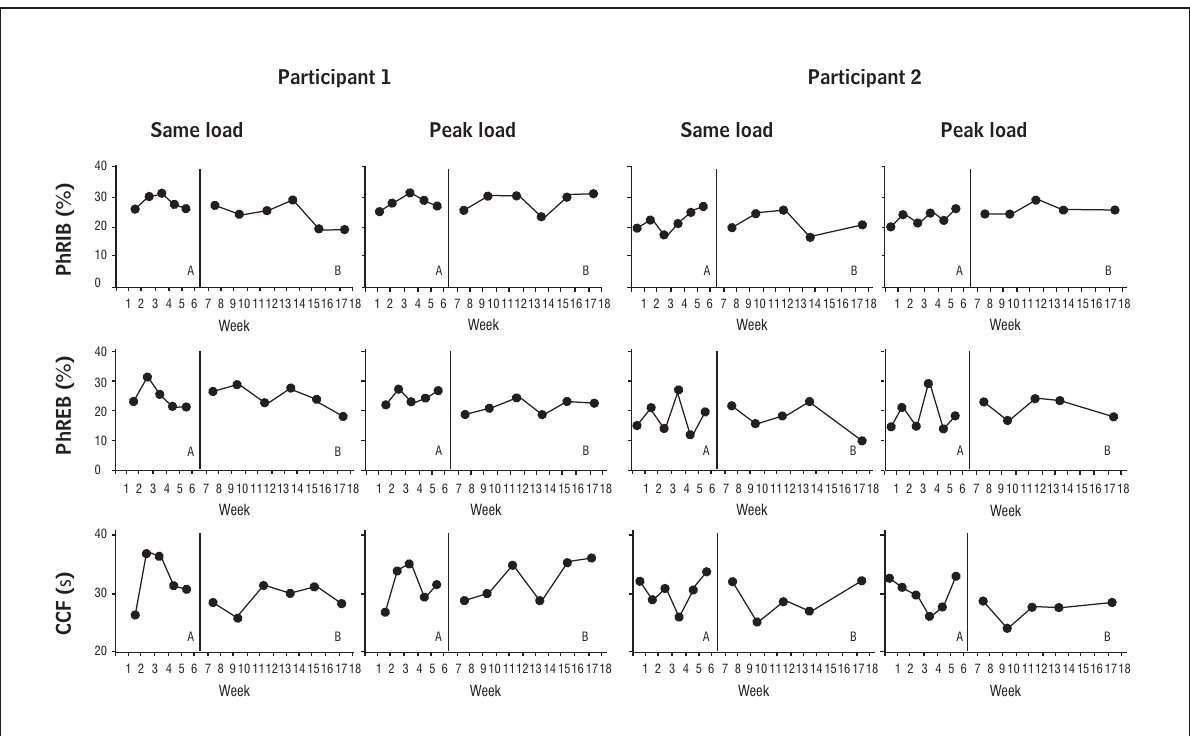
Figure 2 - Graphics of TAM variables during baseline (A) and intervention (B) phases at rest, same load and peak loak on the two participants studied Source: Research